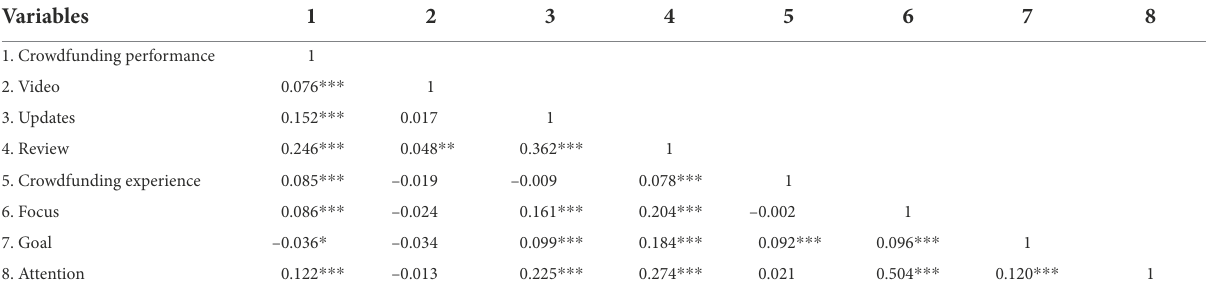
TABLE 2 Correlation matrix analysis of key variable; Pearson’s r .